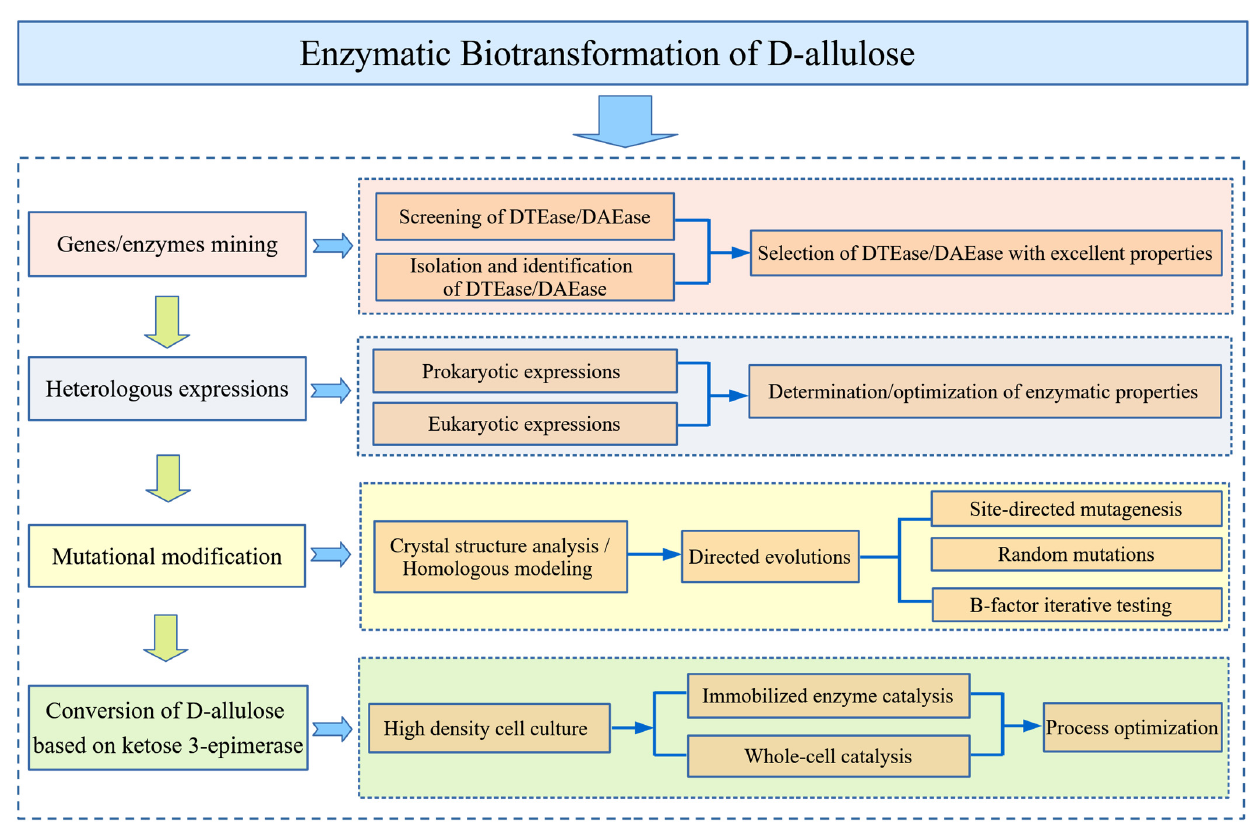
Figure 2. Overview of enzymatic biotransformation processes of D -allulose based on D -tagatose 3-epimerase (DTEase)/ D -allulose 3-epimerase (DAEase).